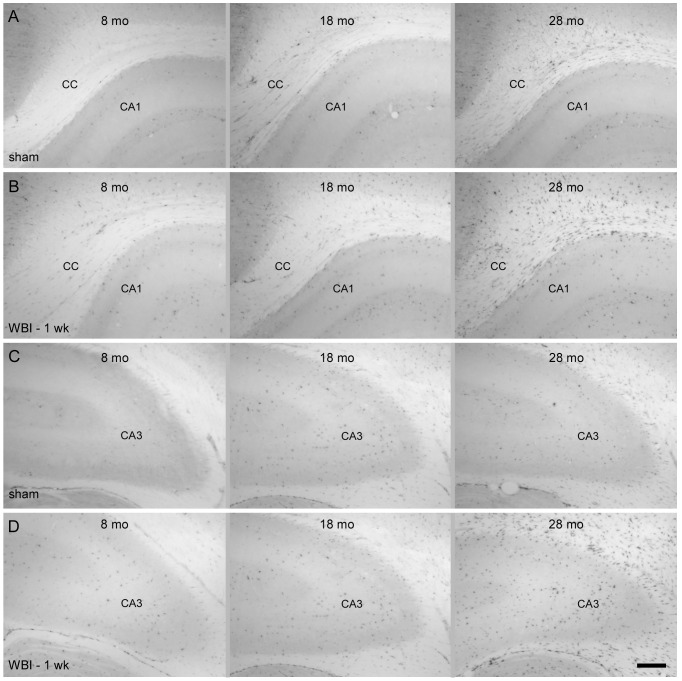
IHC labeling with ED1.Images illustrating ED1 labeling in the CC and CA1 (A, B) and CA3 (C, D) of young adult, middle-aged and old rats following sham irradiation (A, C) or at 1 week after WBI (B, D), Scale bar = 250 µm.